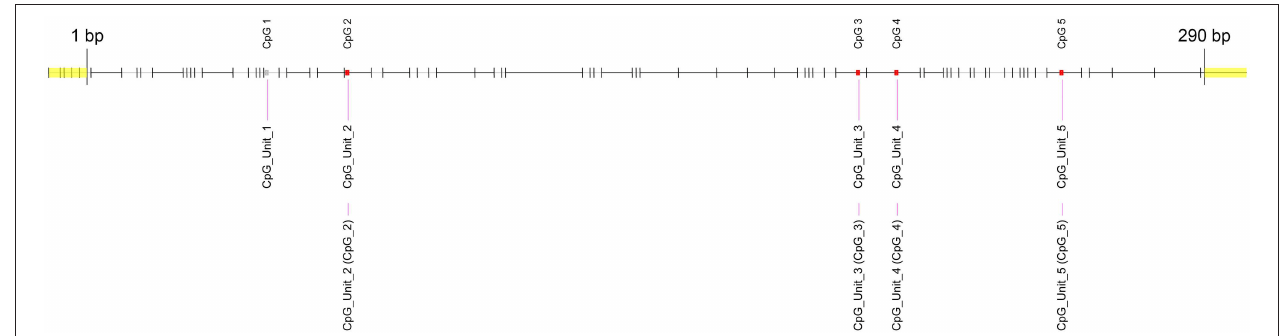
TABLE 4 | ampliconPredict result for the 290bp LEP amplicon.